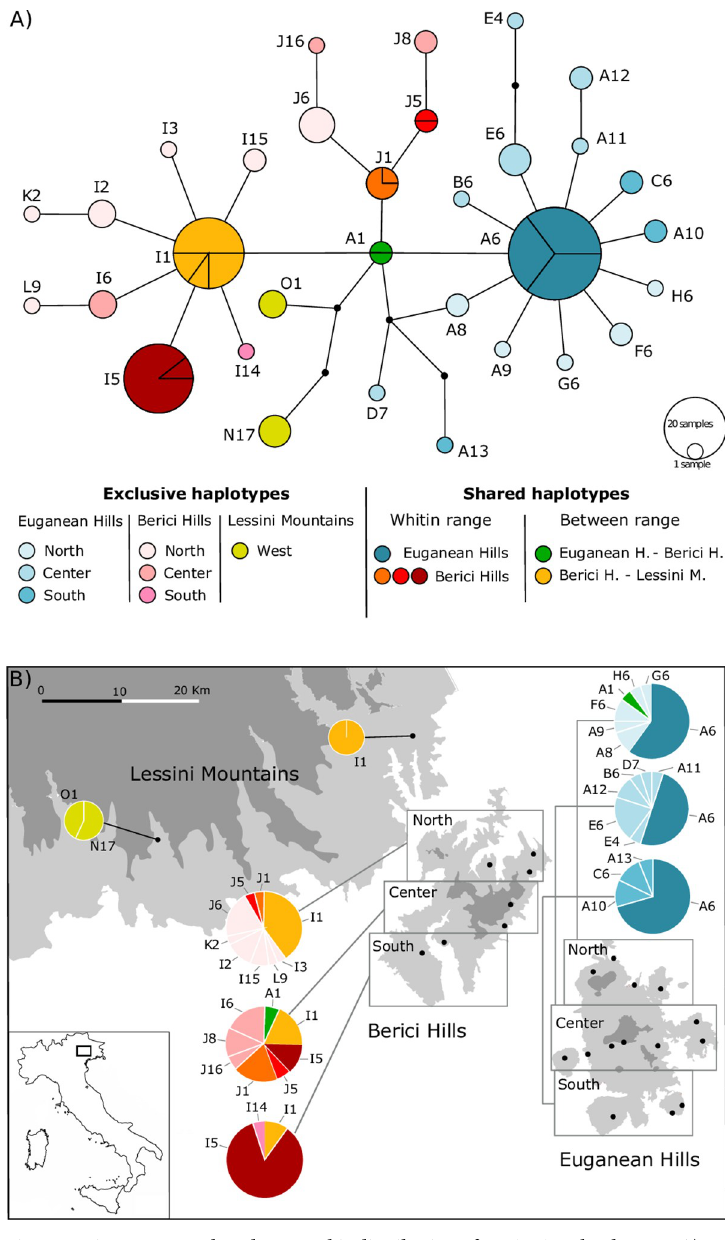
Fig 1. Parsimony network and geographic distribution of B . vicetinus haplotypes. A) Haplotypes network based on the combined dataset (COI-tRNALeu-COII and 12S-CR). Each haplotype is represented by a circle, and the area of the circle is proportional to its frequency. Lines within haplotypes circles indicate the proportions shared between collection areas. The colours represent differences in geographic distribution, and small black dots symbolize missing intermediate or unsampled haplotypes. Codes indicate the haplotype ID, reported in Table 1. B) Map showing the proportional geographic distribution of bush-cricket haplotypes across sampled populations. Map republished from [62] under a CC BY license, with permission from [Regione del Veneto–L.R. n. 28/76 –Formazione della Carta Tecnica Regionale], original copyright [2020]. ( 5’-CTCTATCAARRTAAYCCTTT-3’ ) [41] were used to amplify the 12S-CR fragment. Amplifications were performed in 20 μ l reactions (1x PCR Go Taq Flexi buffer—Promega, 2.5 mM MgCl2, 0.1 mM dNTPs, 0.5 μ M for each primer, 0.5 U of Taq polymerase—Promega, 2 μ l